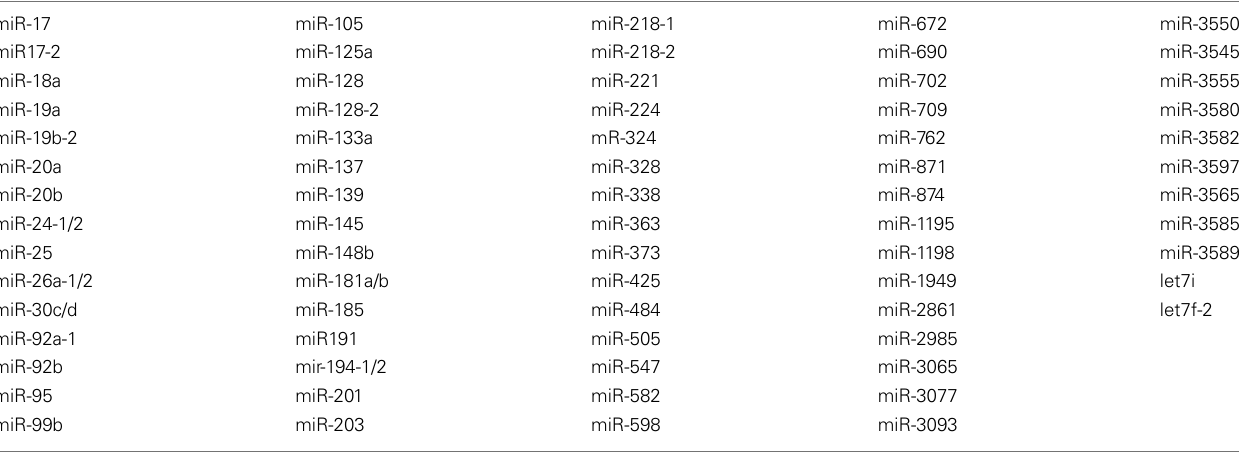
TableA7 | List of potential novel REST miRNA